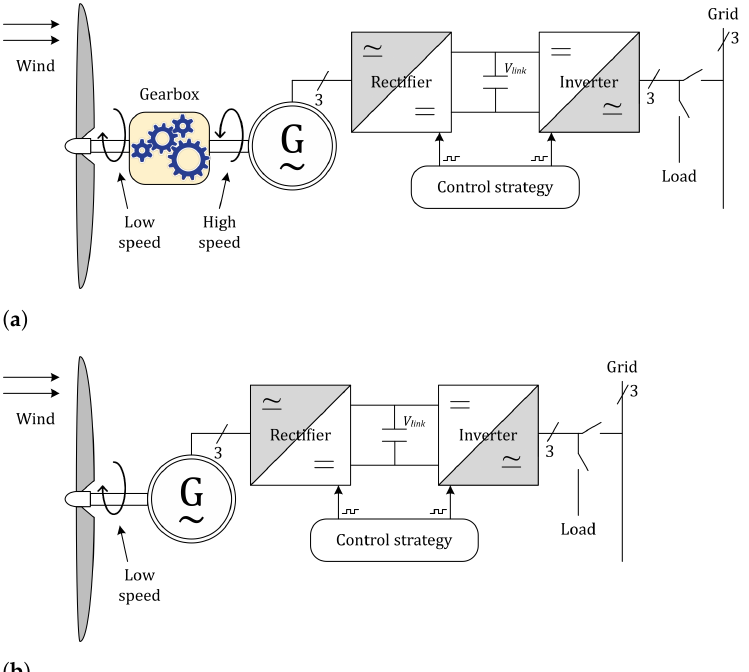
Figure 1. Typical wind energy conversion systems: ( a ) Use of a transmission gearbox and high-speed generator, ( b ) Without a transmission gearbox utilizing a low-speed